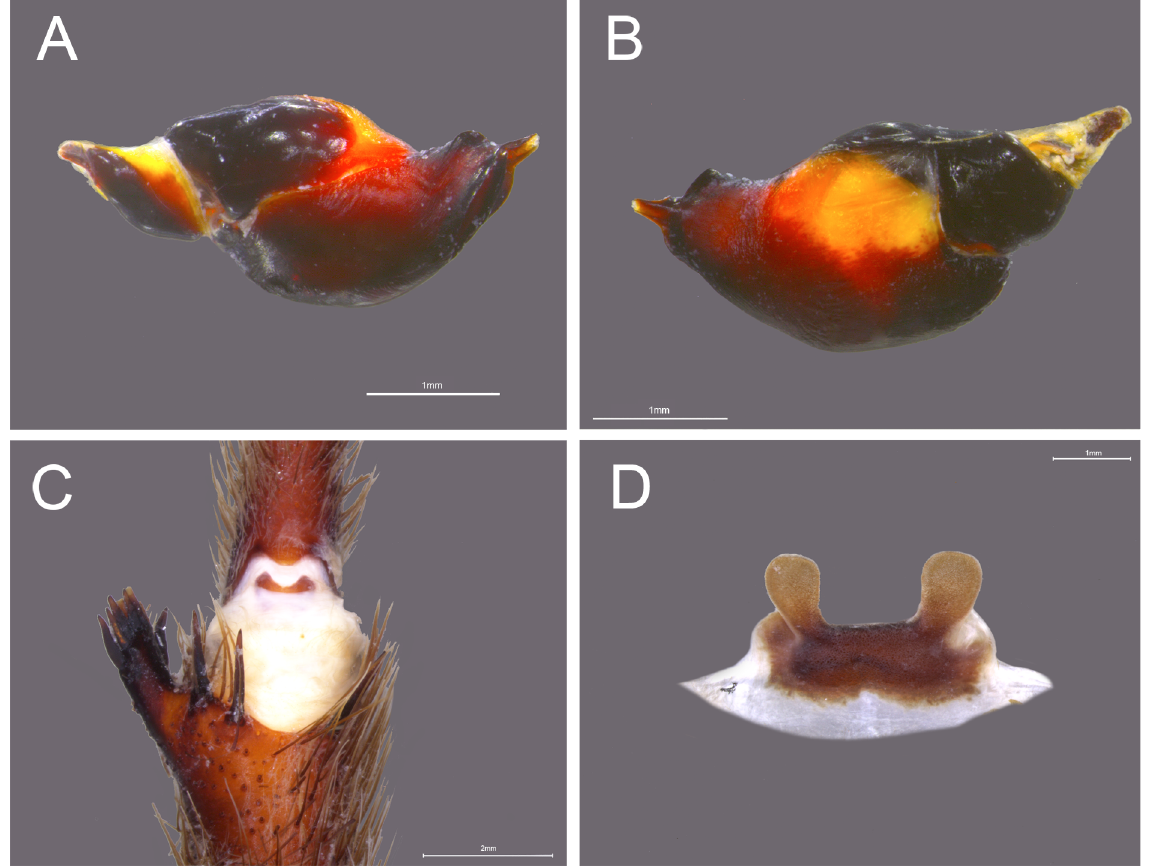
Fig. 25. Umbyquyra tucurui gen. et sp. nov. A–C . Holotype, ♂, Tucuruí, Pará, Brazil (IBSP 104834). A . Palp, prolateral. B . Retrolateral. C . Tibial apophysis, ventral. D . Paratype, ♀, spermathecae, dorsal (IBSP